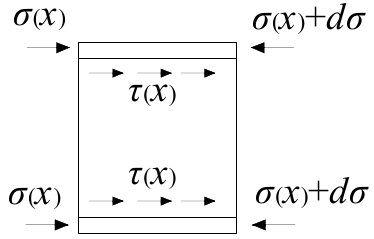
Figure 14. Stress distribution along the micro steel.